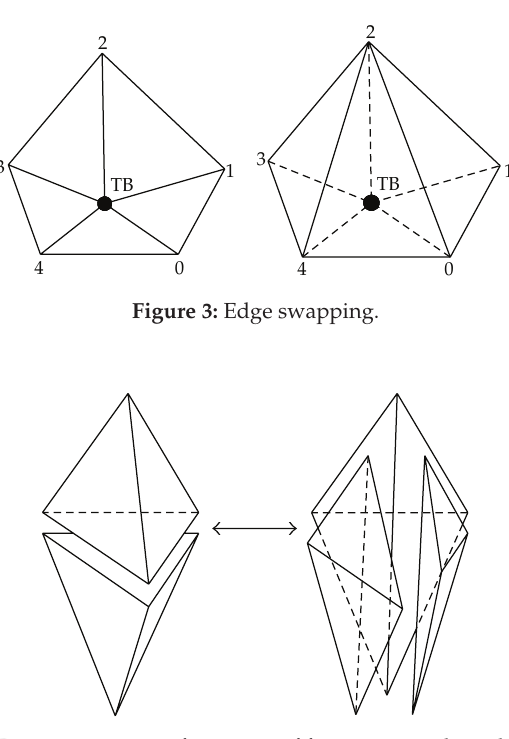
Figure 4: Face swapping configuration of five points in three